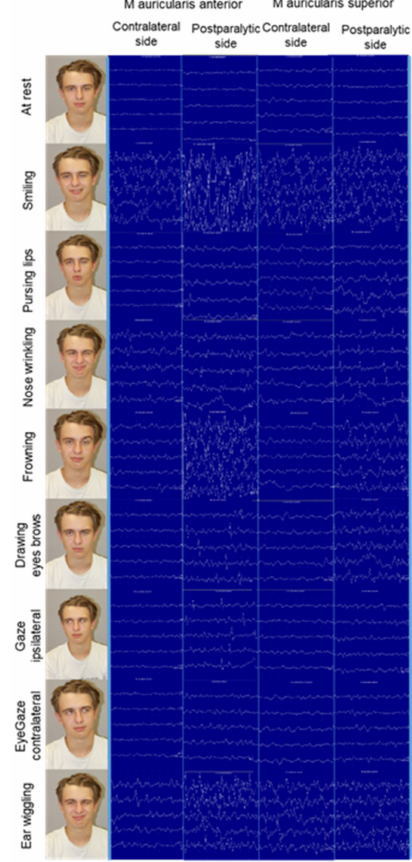
Figure 2. Example of a patient with postparalytic facial synkinesis on the left side. For most mimic tasks, the single-channel EMG activity was heavily increased on the postparalytic side in comparison to the contralateral side, here shown for the auricularis anterior and superior